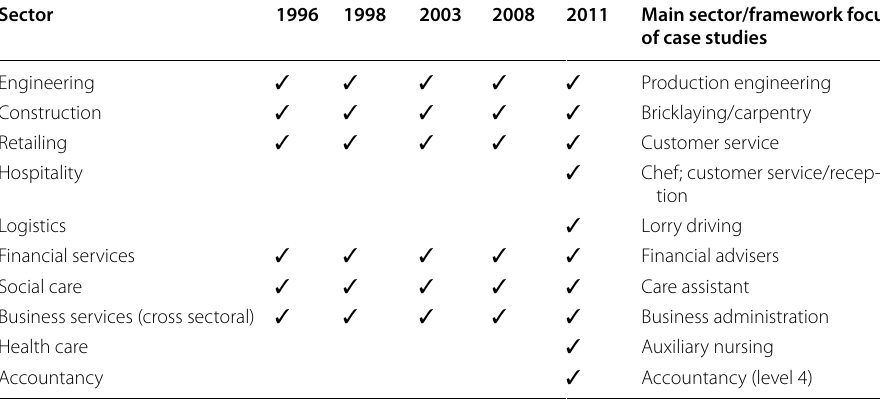
Table 1 Sector coverage in the Net Costs Studies 1996–2011. Source: Net Costs